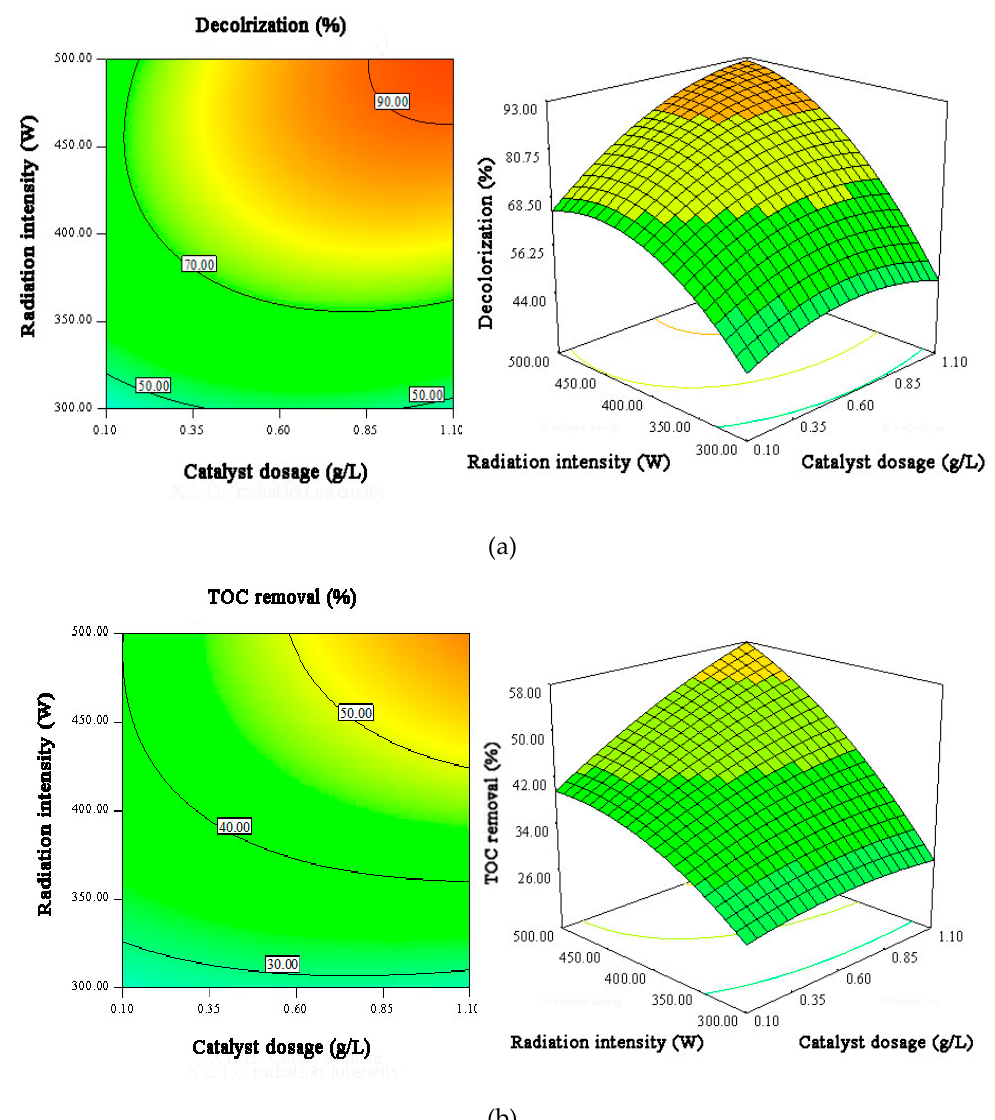
Figure 10. The contour plots and 3D surface responses for the effects of catalyst dosage and radiation intensity on MB decolorization efficiency ( a ) and TOC removal efficiency ( b ).